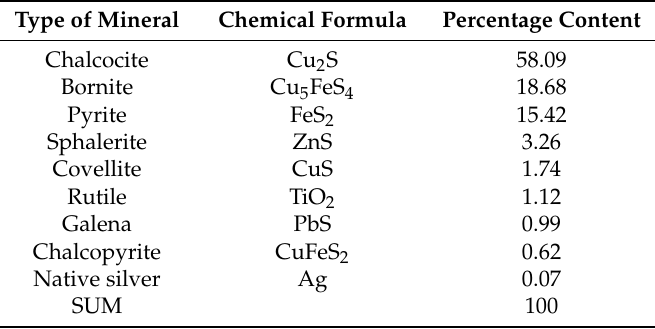
Table 3. Mineralogical characterization of the feed material.